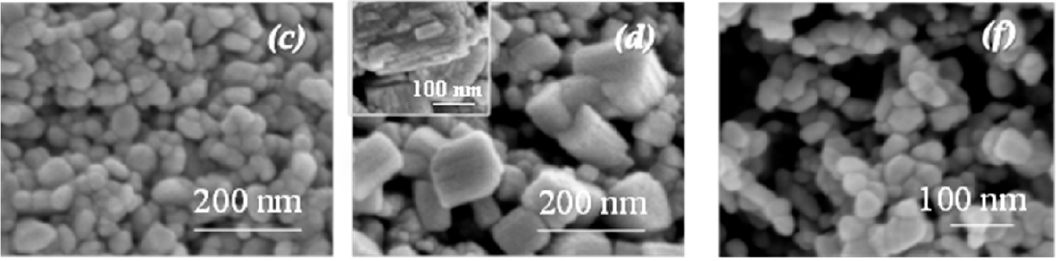
Figure 2. FE-SEM images of the calcined powders: ( a ) WO 3 ; ( b ) W-Sn(0.1); ( c ) W-Sn(0.3); ( d ) W-Sn(0.5); ( e ) ZnO nanoprisms; ( f ) ZnO nanospheres.